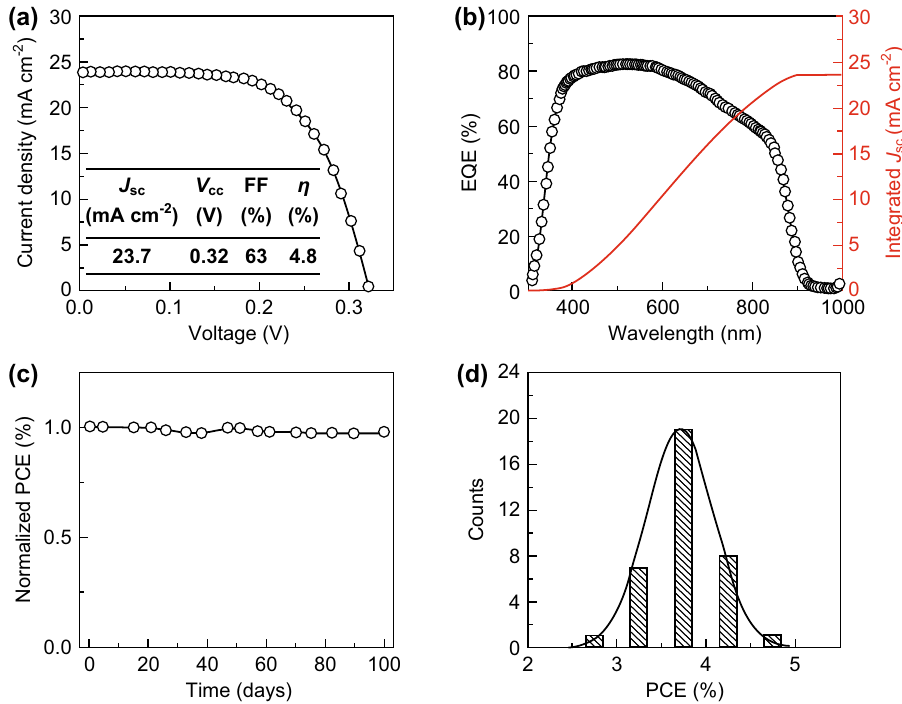
Fig. 24 a J – V curve and b external quantum efficiency (EQE) spectrum and integrated J sc for the optimized FASnI 3 PSC; c recombination time constant of FASnI 3 PSC s as a function of the open-circuit voltage; and d relationship between PCE of the FASnI 3 PSC and the amount of added SnF 2 in the presence of pyrazine. Reproduced with permission Ref. [32]. Copyright (cid:2) 2016 American Chemical